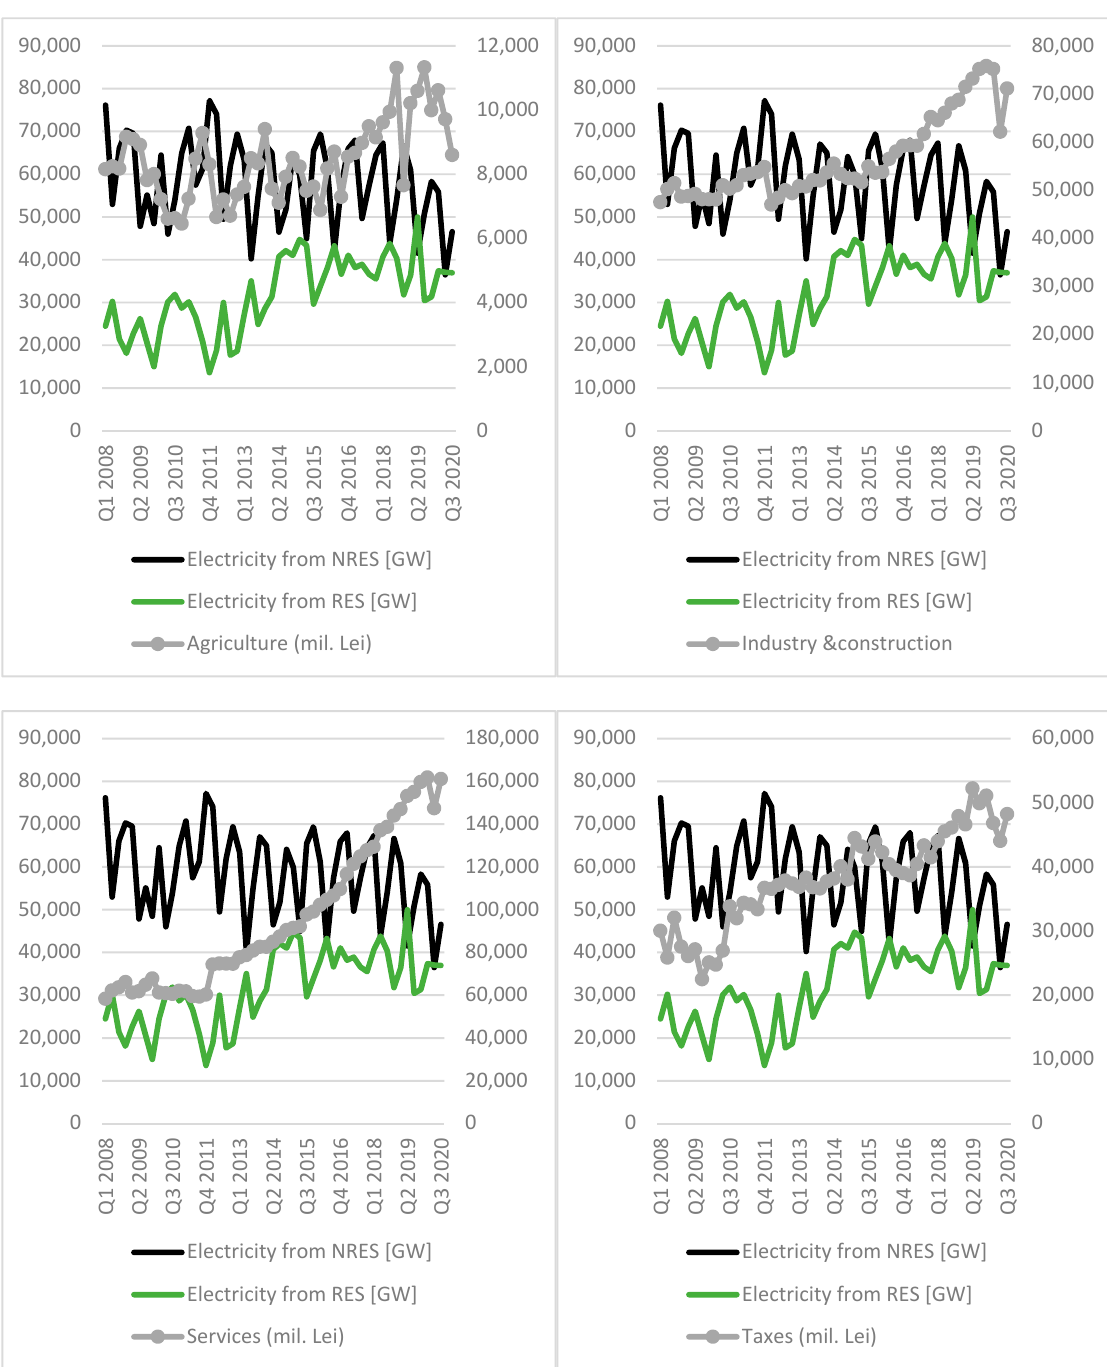
Figure 3. Romania’s quarterly GDP (million lei) from different sources and electricity consumption, in the period Q1 2008–Q3 2020. Own representation adapted from data [50,53].